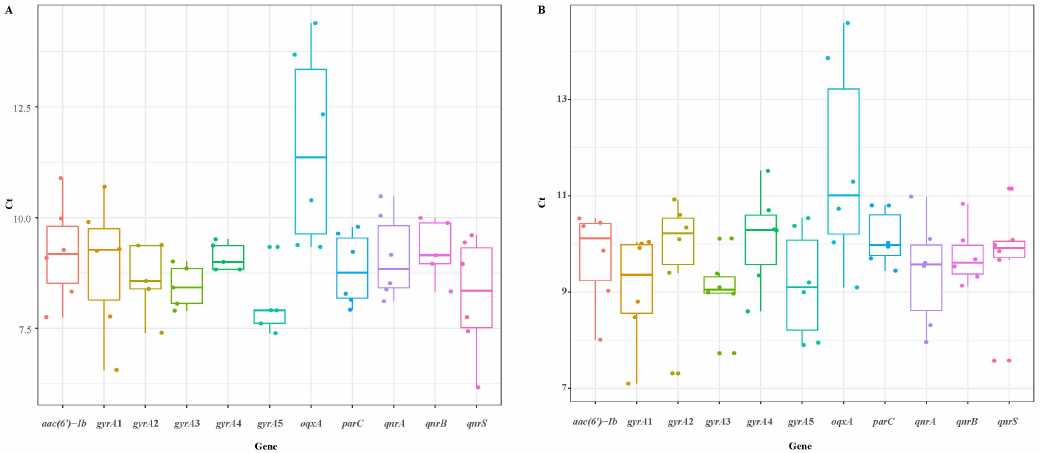
Figure 7. Ct values of qPCR with plasmid DNA reference materials stored at 4 ◦ C and − 20 ◦ C. Foods 2022 , 11 , x FOR PEER REVIEW ( A ) Short-term storage stability at 4 ◦ C. ( B ) Long-term storage stability at − 20 ◦ C.